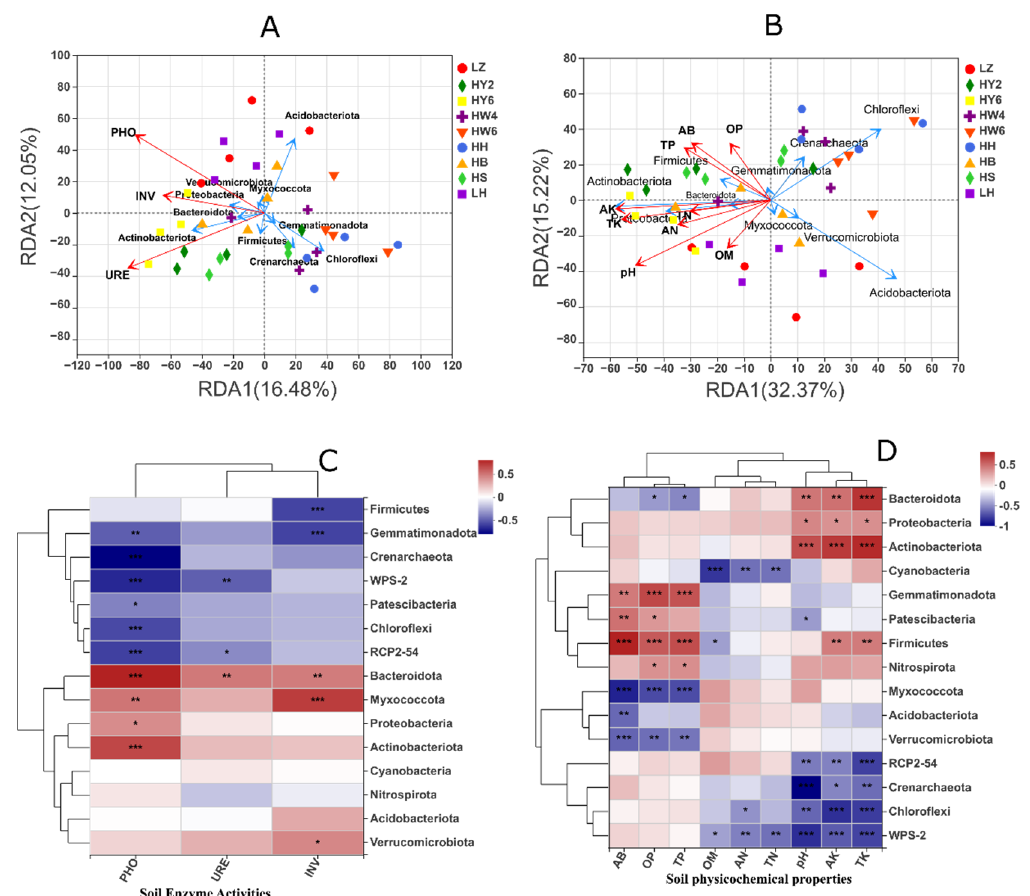
Figure 7. The correlation between bacterial phyla, soil physicochemical properties, and soil enzyme activities. ( A ) Redun- dancy analysis (RDA) of the dominant phyla and soil enzyme activities. ( B ) Redundancy analysis (RDA) of the dominant phyla and soil physiochemical properties. ( C ) Spearman’s correlation coefficient of soil enzyme activities and bacterial phyla. ( D ) Spearman’s correlation coefficient of soil physicochemical properties and bacterial phyla. LZ, HY2, HY6, HW2, HW6, HH, HB, HS, and LH; continuous cropping of C. chinensis for 5 years, maize continuous cropping for 2 years, maize continuous cropping for 6 years, P. multiflorum continuous cropping for 2 years, P. multiflorum continuous cropping for 6 years, sweet potato continuous cropping for 2 years, F. thunbergia continuous cropping for 2 years, cabbage continuous crop ‐ ping for 2 years, and fallow field, respectively. The length of the species arrow indicates the proportion of species change, and the length of the physicochemical properties arrow indicates the impact on the dominant phylum; the longer the arrow, the greater the impact. Asterisks (*, **, and ***) show significant correlation at p ‐ value < 0.05, 0.01, and 0.001, respectively.